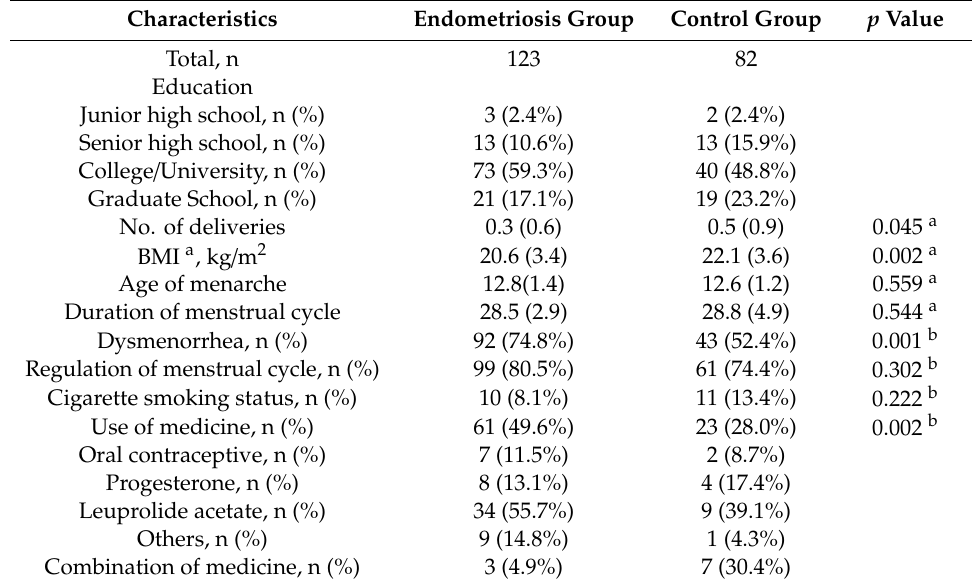
Table 1. Clinical characteristics of women with endometriosis and control.